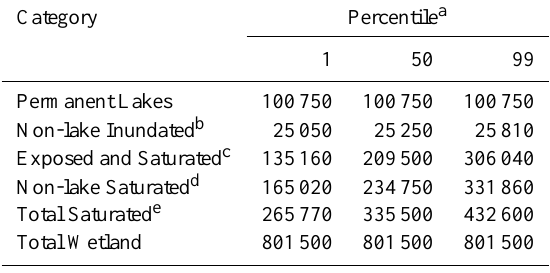
Table 4. Estimates of JJA average areas (km 2 ) of wetland zones, totaled across the WSL, over the period 2001–2010.